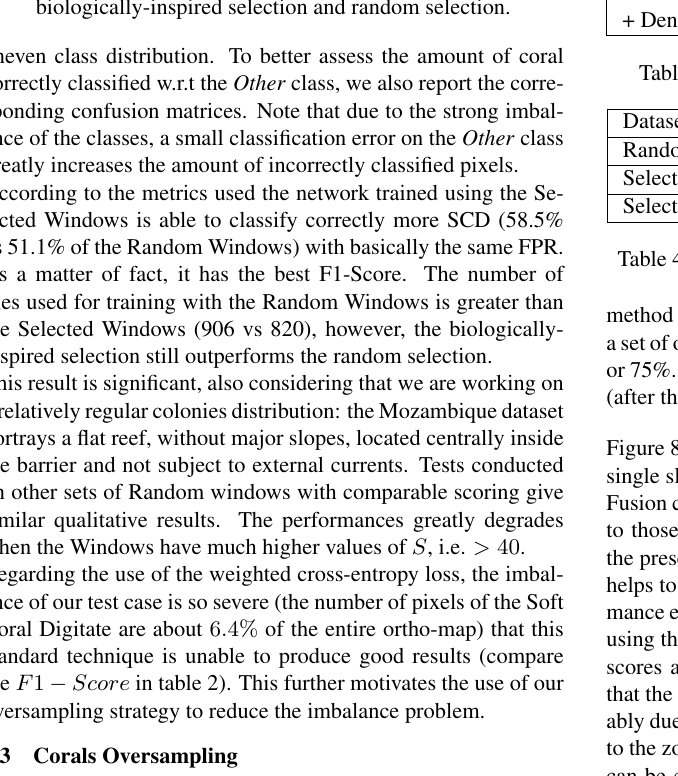
Table 2. Comparison of accuracy and F1-Score between the biologically-inspired selection and random selection.